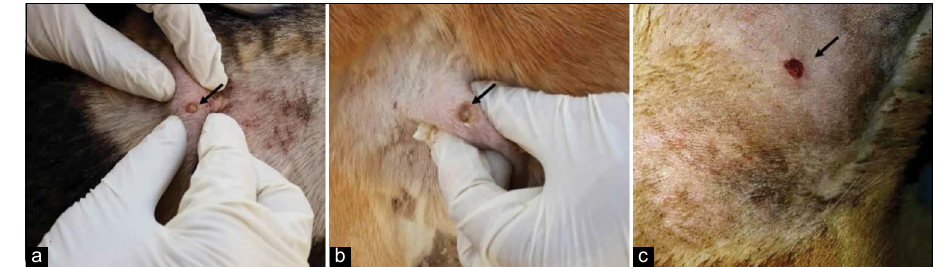
Figure-2: Untreated group. (a) Zero day of the experiment, the skin showing erythema, pruritis, and pus-filled pustules (arrow). (b) 10 th day without treatment (DWT), the skin showing lesion with hyperemic rim, erythema and pus center (arrow). (c) 14 th DWT, the skin showing epidermal collarette the start of scar formation over the lesion Table-2: Biochemical profile of experimentally induced pyoderma in dogs treated by Aloe vera 20%; 40%; and gentamicin 0.1% ointments. Variables